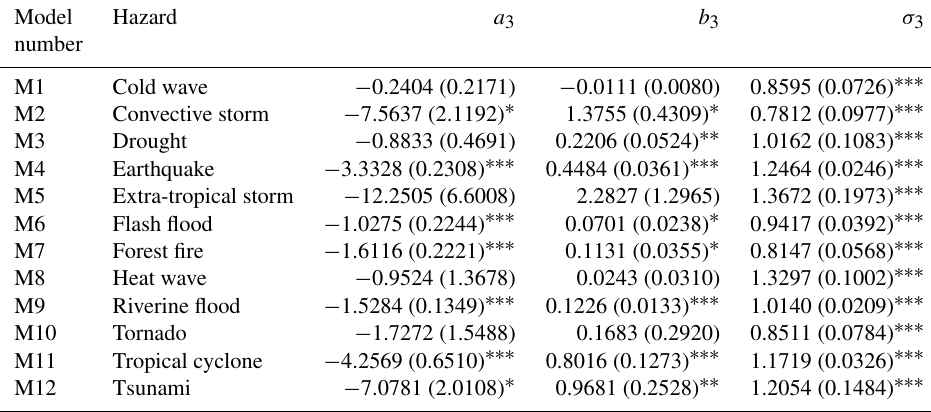
Table 2. Statistics of parameters of 12 simple linear regression models for deriving equivalent hazard magnitudes a